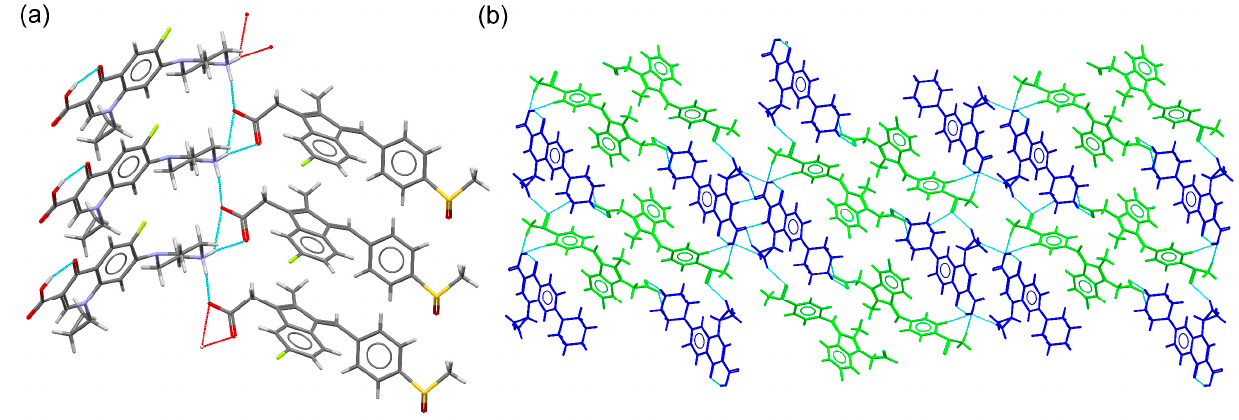
Figure 6. ( a ) Detailed view of the ribbon structure in the molecular salt CIP–SLD. ( b ) Packing arrangement of CIP cations (blue) and SLD anions (green) in the crystal structure of CIP–SLD.